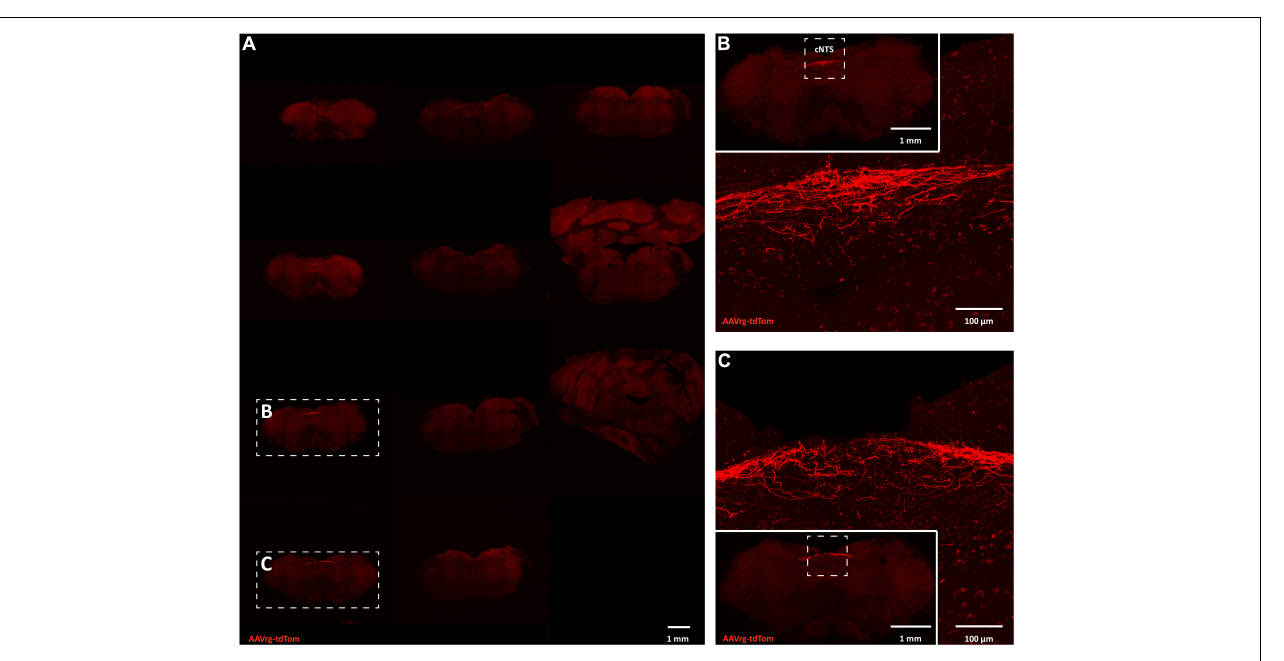
FIGURE 3 | Sensory neurons innervating the aortic arch terminate in the nucleus of the solitary tract. (A) Large scans of coronal sections of hindbrain revealing expression of tdTom within fibers in the caudal nucleus of the solitary tract (cNTS; n = 4). (B,C) Higher magnification representative image of the